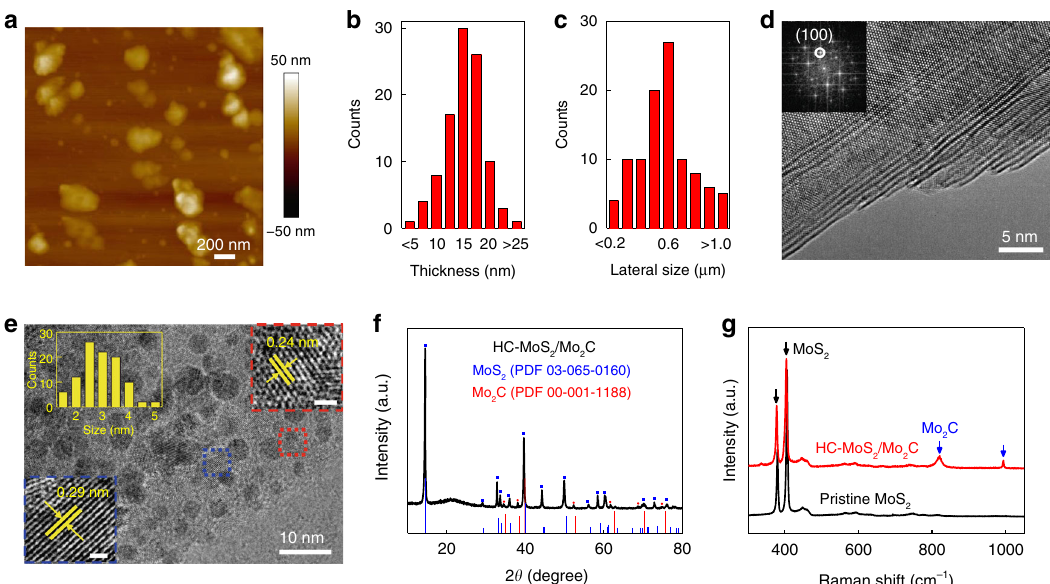
Fig. 2 Material characterization. a Atomic force microscopy image and statistical analysis of ( b ) the lateral size and c the thickness of the 2D MoS 2 fl akes. d High resolution transmission electron microscopy (HRTEM) image of the 2D MoS 2 . Inset is the corresponding fast Fourier transform (FFT) pattern. e HRTEM image of the HC-MoS 2 /Mo 2 C. The insets are a histogram of the lateral size of the Mo 2 C nanocrystals, and two high magni fi cation HRTEM images of a MoS 2 fl ake (the blue dotted box) and a Mo 2 C nanocrystal (the red dotted box). The scale bars in the insets are 1 nm. f X-ray diffraction pattern and ( g ) Raman spectra of the 2D MoS 2 and the HC-MoS 2 /Mo 2